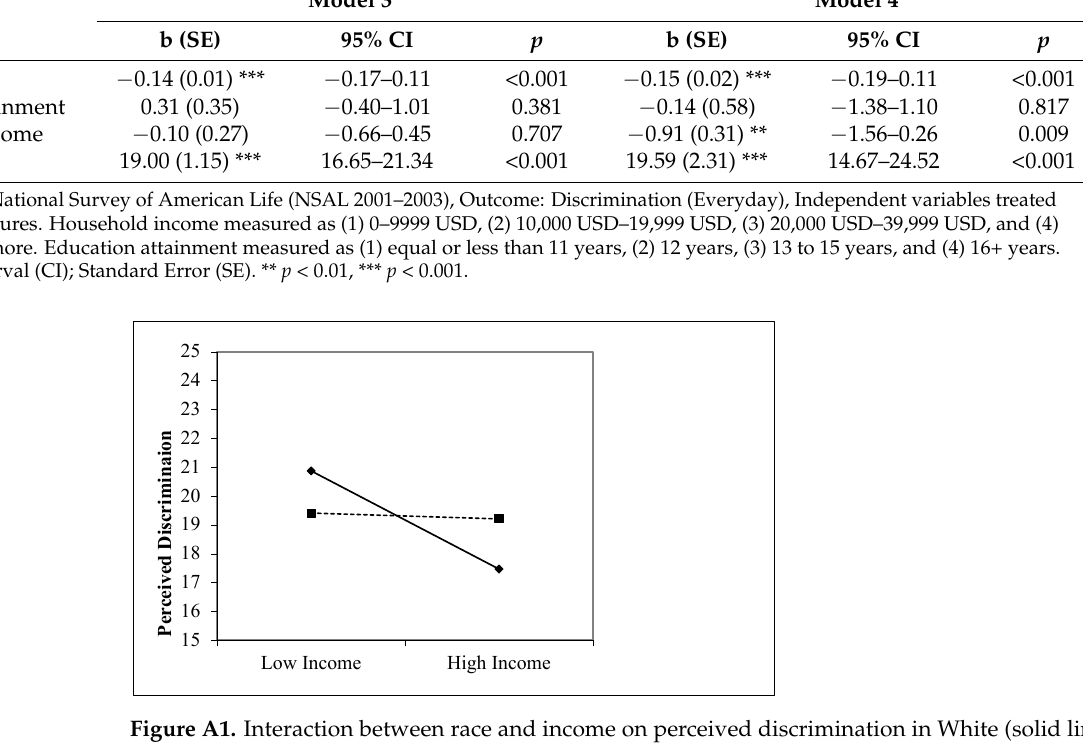
Table A1. Summary of linear regressions on the effects of educational attainment and household income as interval vari- ables on perceived discrimination in African American and Non-Hispanic White men in the National Survey of American Life (sensitivity analysis).